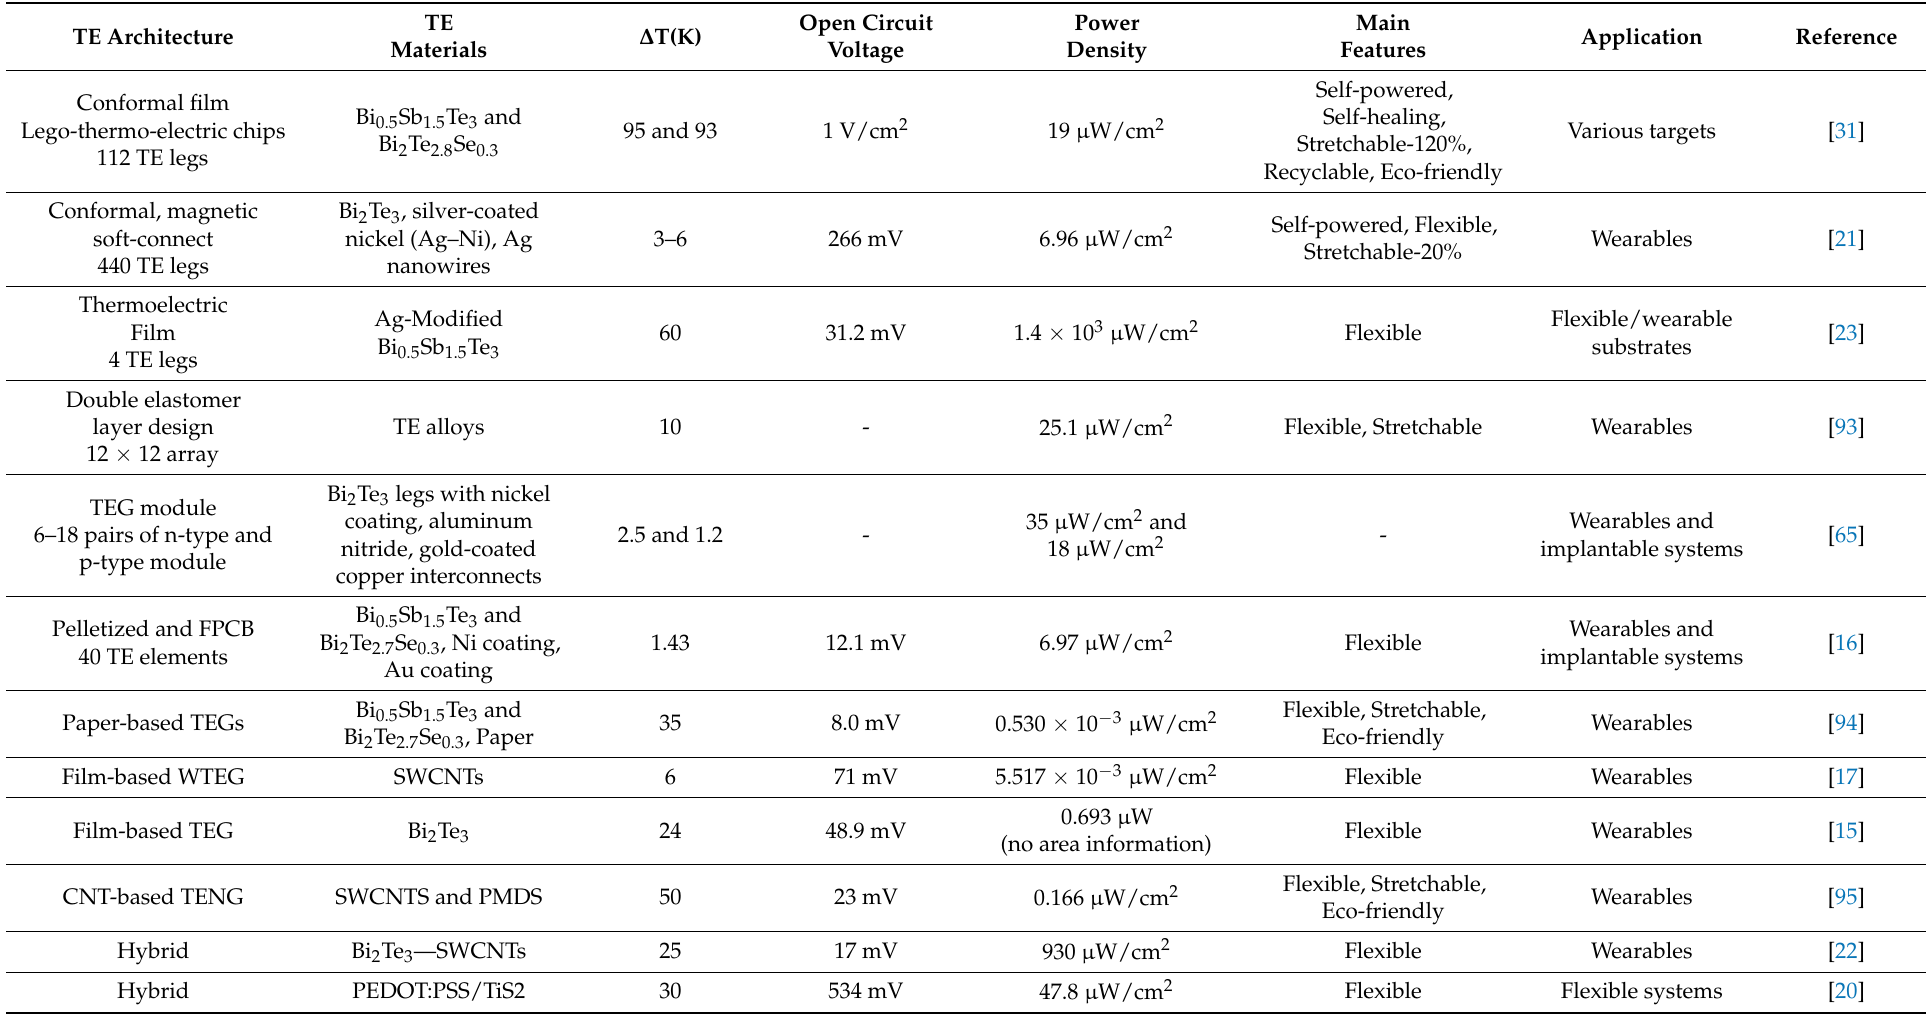
Table 3. Analysis of WTEGs based on organic and inorganic thermoelectric